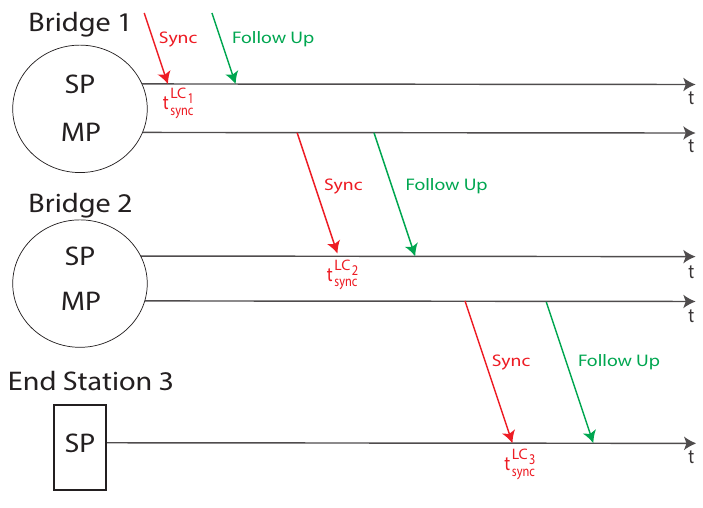
Figure 6. The gPTP synchronization